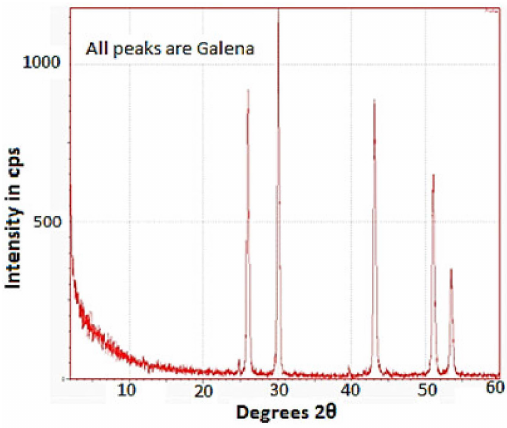
Figure 9. The XRD pattern of the as-received galena